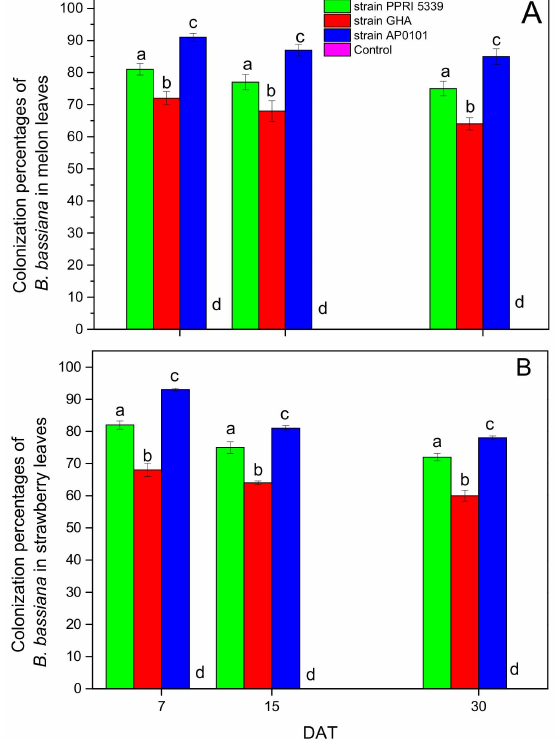
Figure 2. Mean percentage of colonized leaf pieces (% ± sd; n = 200 pieces/treatment) in ( A ) C. melo leaves ( B ) Fragaria sp. leaves. Treated plants were watered with 10 mL of B. bassiana conidial suspension of 10 8 conidia/mL at the stage of four leaves, 25 leaves were sampled from each treatment plot, 8 pieces from each leaf were examined, means of the same plant and DAT marked with the same letter did not differ significantly (Tukey-Kramer test, p < 0.05); DAT: days after treatment.